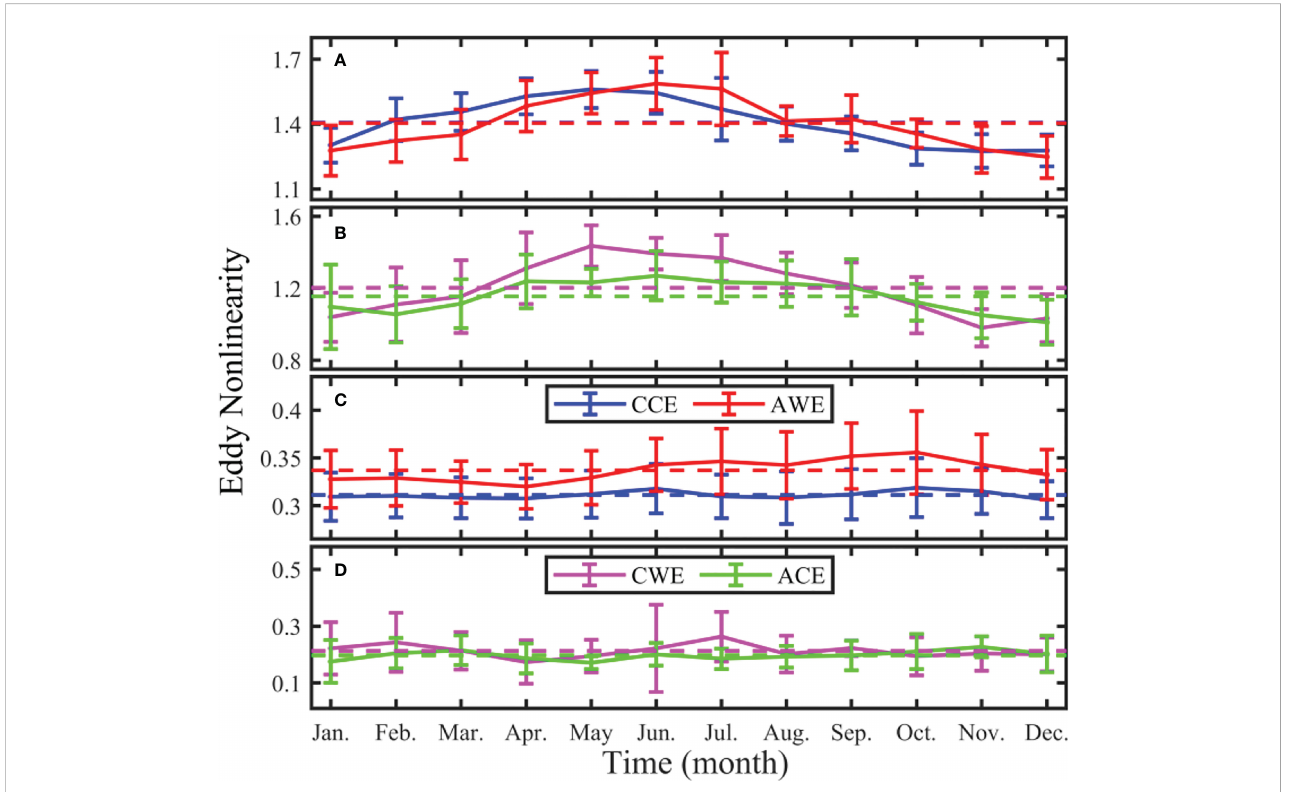
FIGURE 5 Monthly distribution of multi-year (2008 ~ 2017) average eddy nonlinearity at the sea surface (A, B) and 1,000 m (C, D) in the STCC area. Blue, red, pink, and green curves represent cyclonic cold-core eddy, anticyclonic warm-core eddy, cyclonic warm-core eddy, and anticyclonic cold-core eddy, respectively. The bar line represents the standard deviation, and the dotted line represents the multi-year average